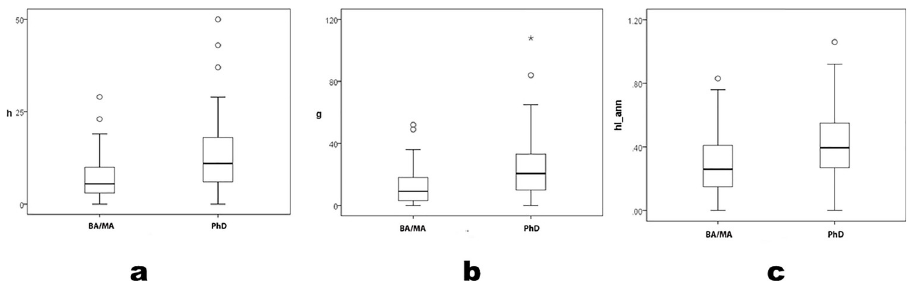
Fig 3. h , g and hIann by grouped BA+MA versus PhD